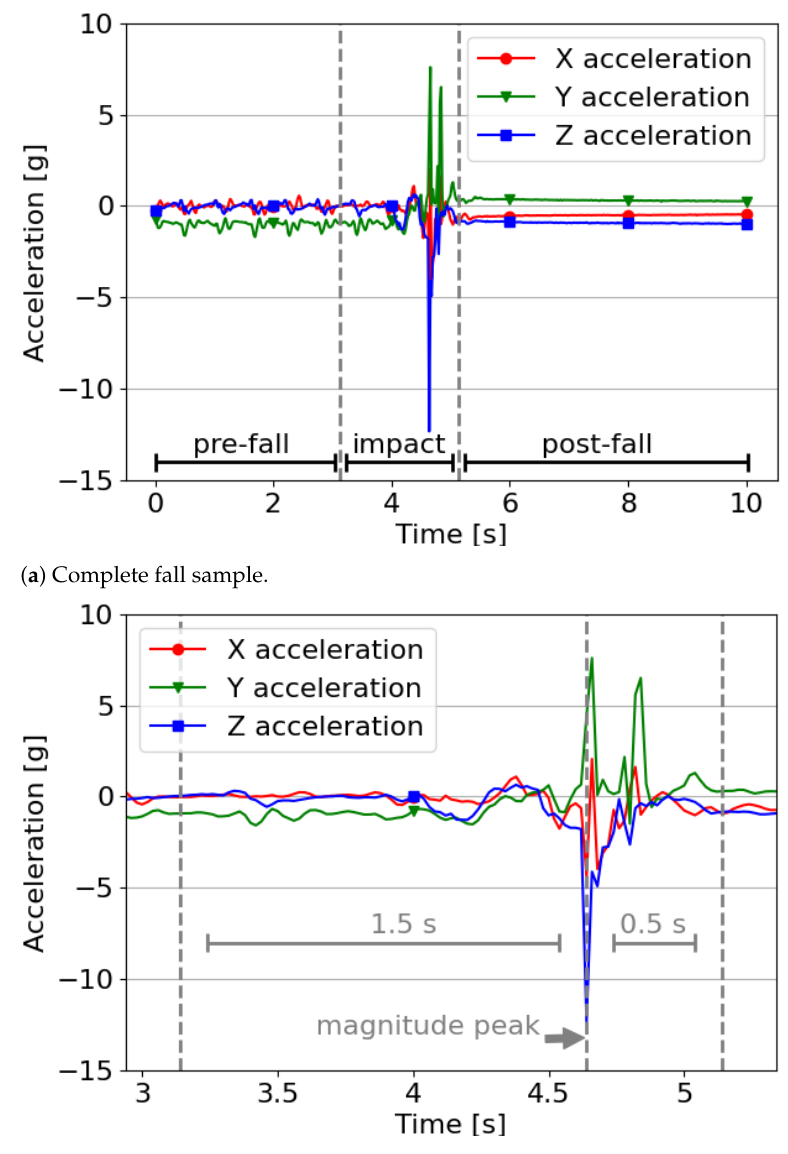
Figure 3. Division of a fall sample into pre-fall, impact and post-fall